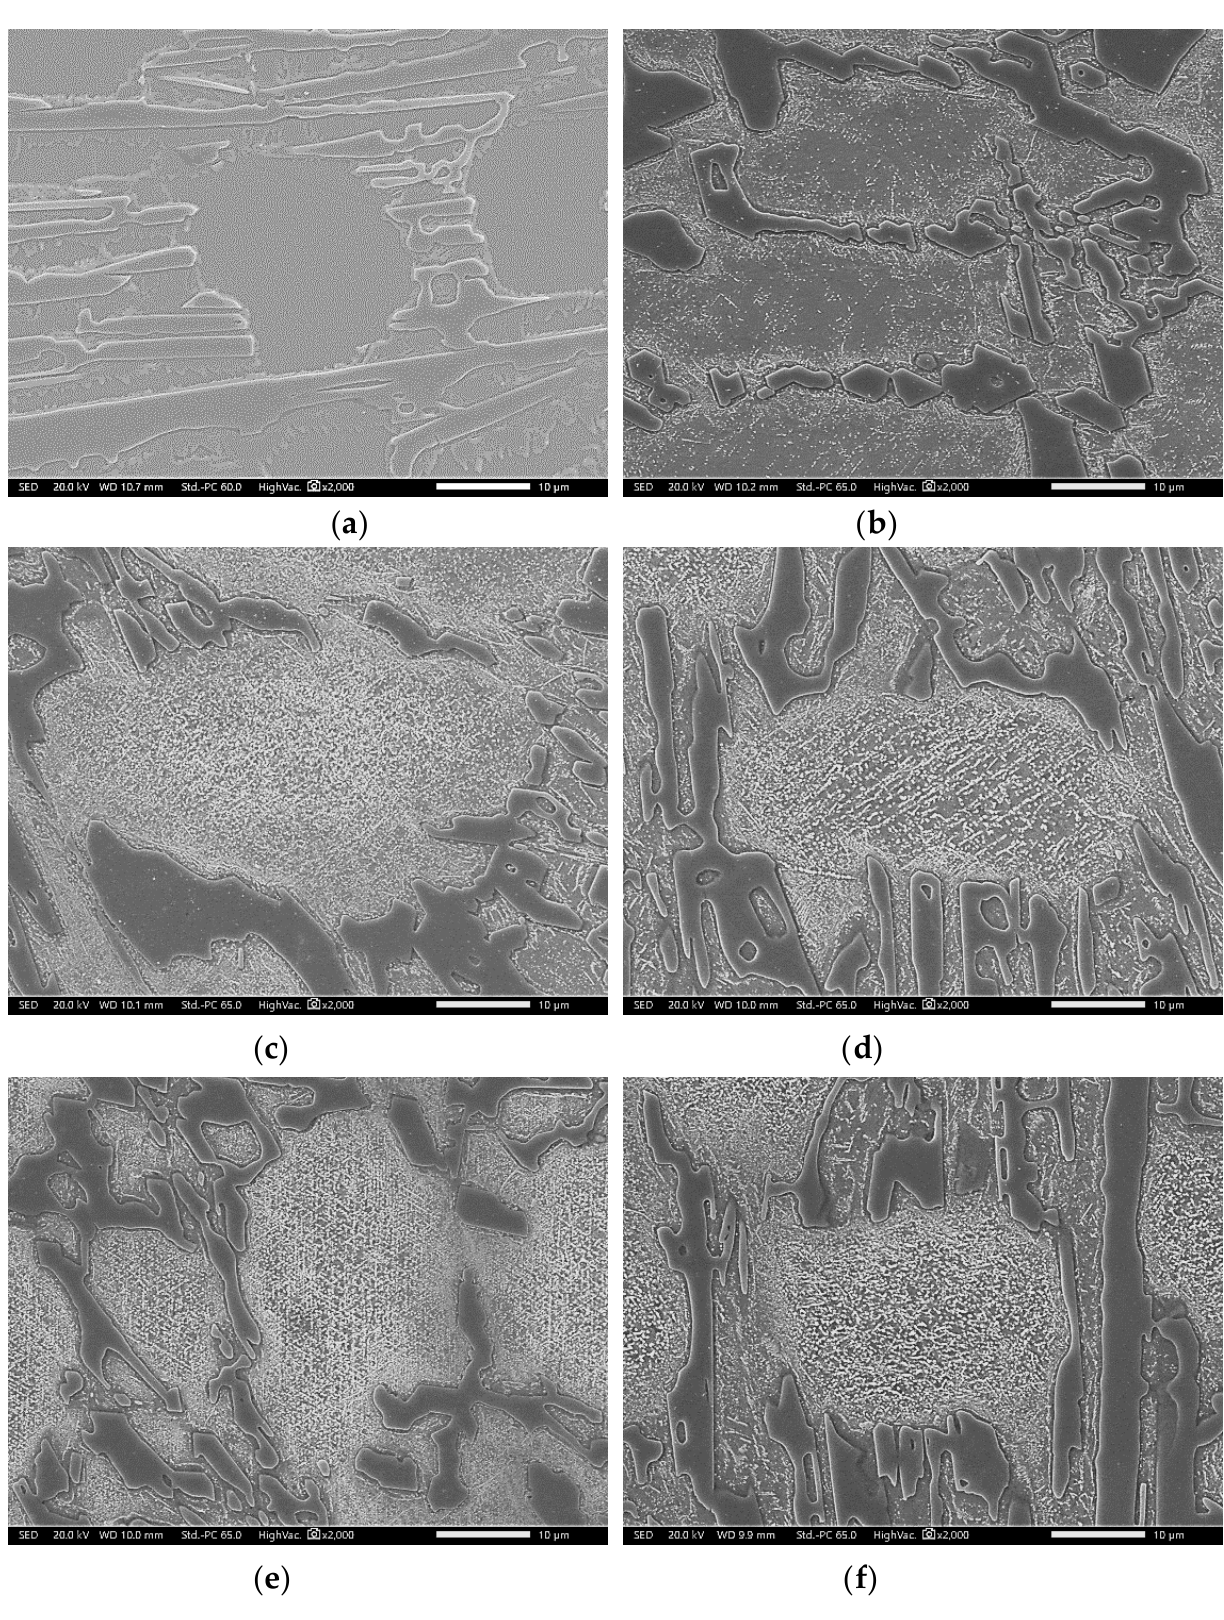
Figure 15. Effect of soaking time at 890 °C on the microstructural evolution of 2427 alloy: ( a ) as cast; ( b ) 10 min; ( c ) 30 min; ( d ) 60 min; ( e ) 240 min; ( f ) 300 min.